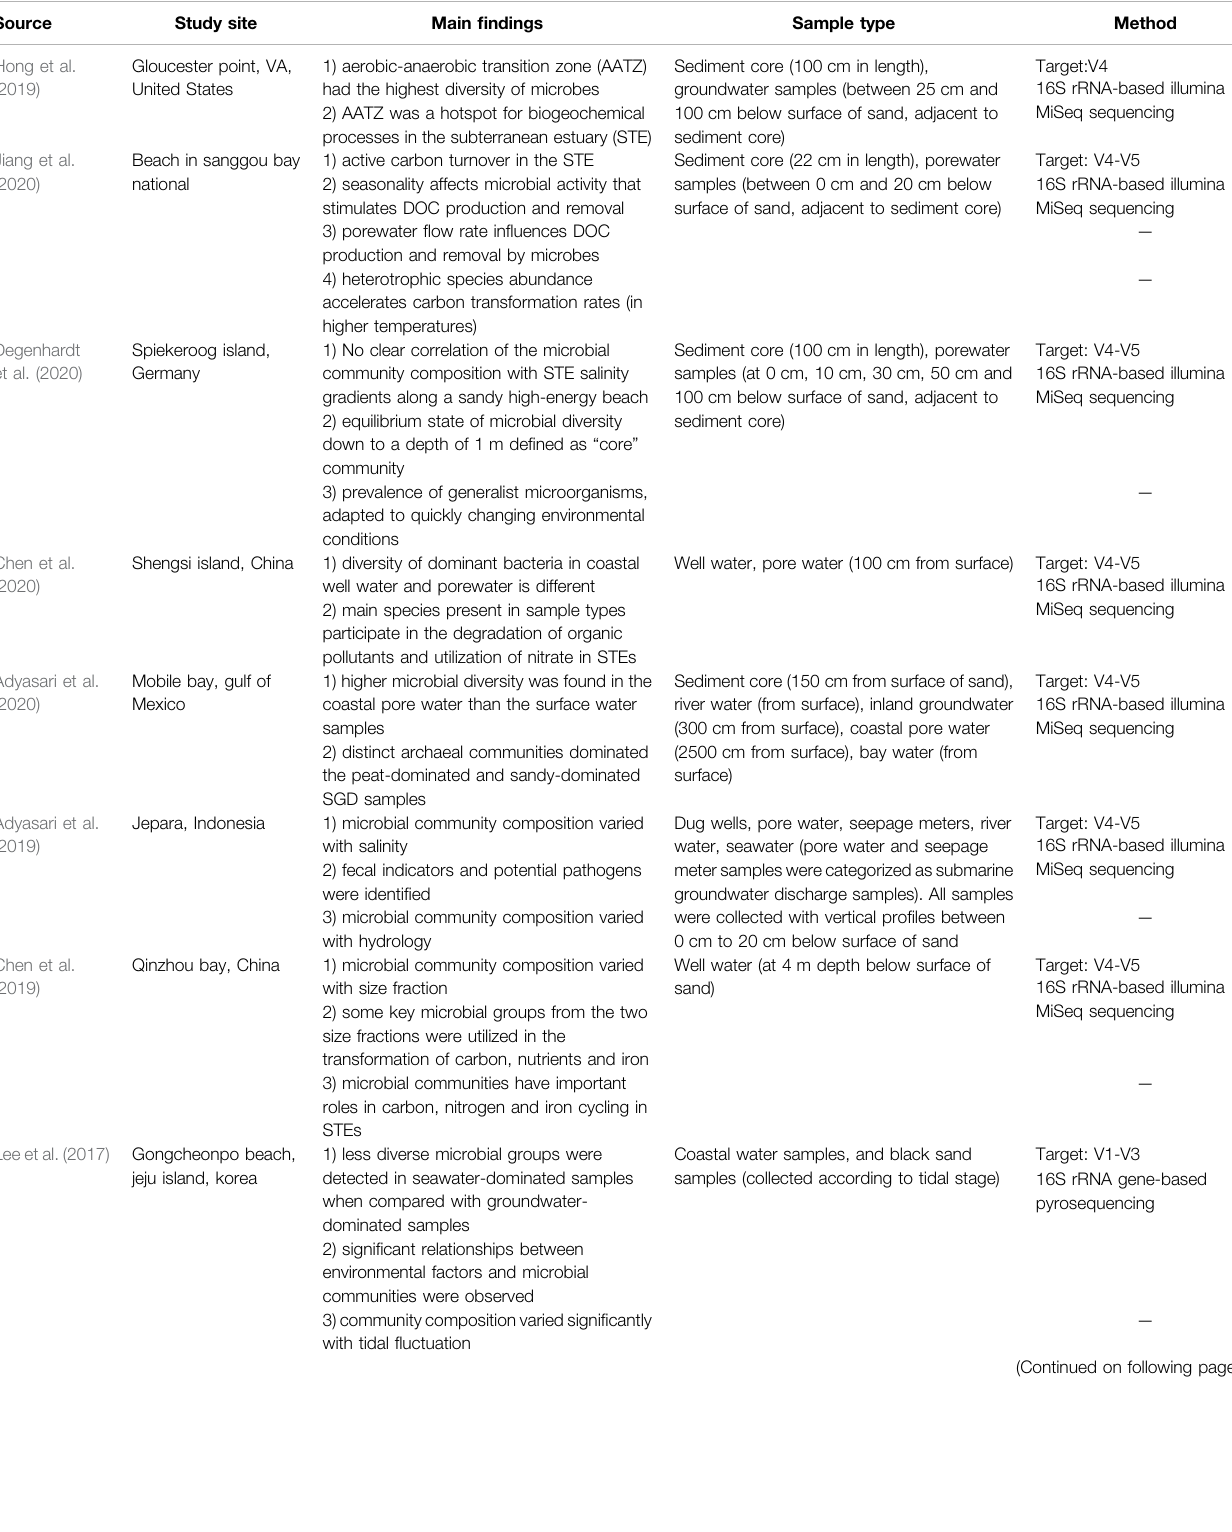
TABLE 1 | Summary of fi ndings on microbial communities in beach